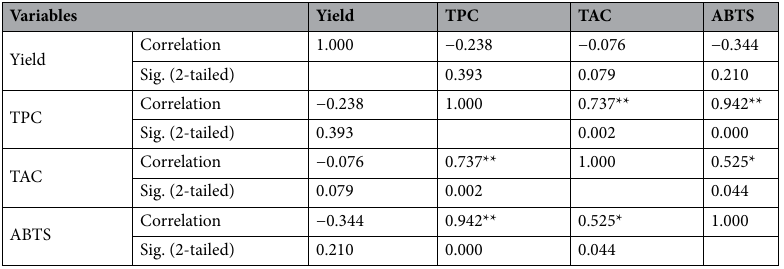
Table 4. Pearson’s correlation coefficient between response variables. *Correlation is significant at the level of p < 0.05; **Correlation is significant at the level of p < 0.01; TPC: total phenolic content; TAC: total anthocyanin content; ABTS: 2,2 ′ -azino-bis-3-ethylbenzothiazoline-6-sulphonic acid.